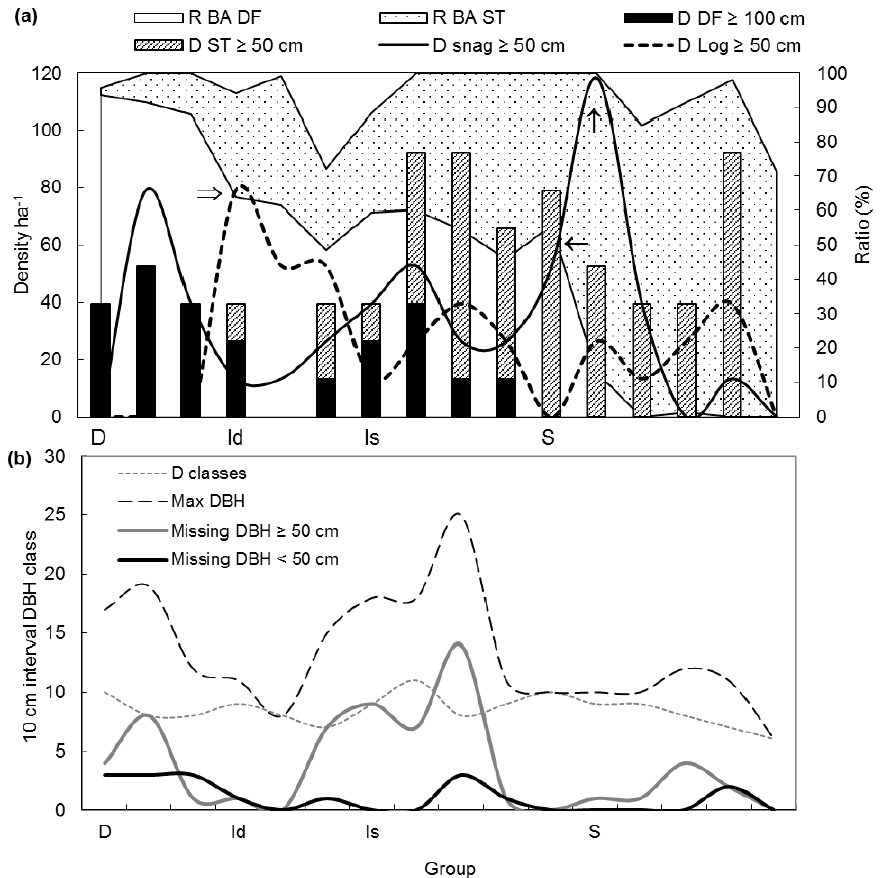
Figure 4. Changes in structural variables attributed to old-growth variables by grouped stands (sub-structures) temporally arranged based on the similarity in clustering analysis and oldest tree age. Variables are shown in Table 2. Solid arrows in (a) indicate pathogen damage and double-line arrows indicate wind damage detected in the